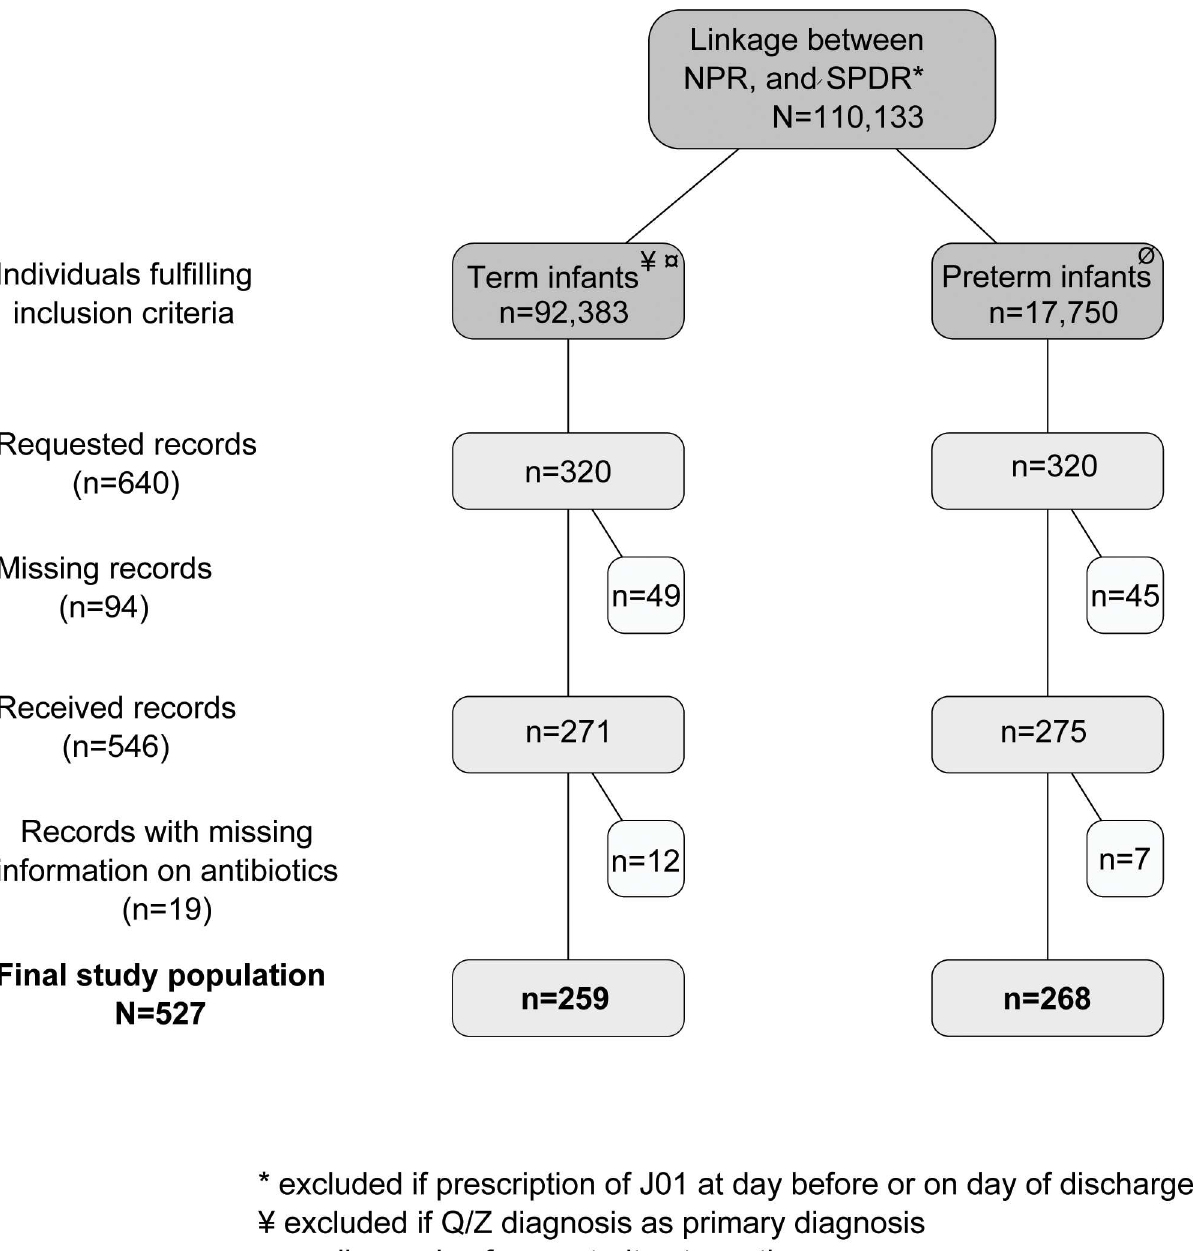
Fig 2. Study population and medical record request for infants 0–12 months. Medical records were randomly selected from a register-based cohort of patients treated in Swedish hospitalsbetween July 2005 and November 2011. Abbreviations: NPR =